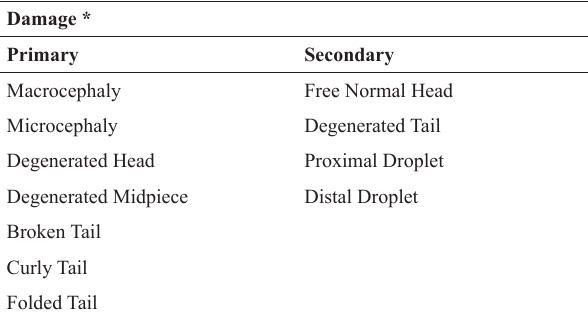
Table 1. List of sperm damage evaluated in Colossoma macropomun . *Adapted from Miliorini et al . (2011).